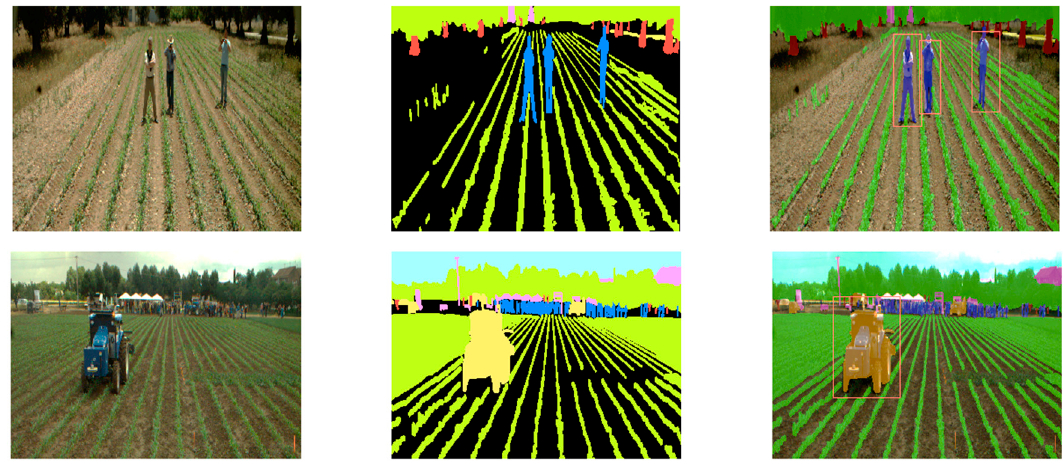
Figure 18. Peoples and a vehicle identified as obstacles in the working environment.